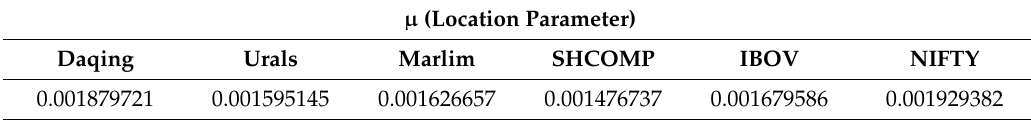
Table A2. MNIG Location parameter µ for Vector 1: Daqing, Urals, Marlim, SHCOMP, IBOV, NIFTY.